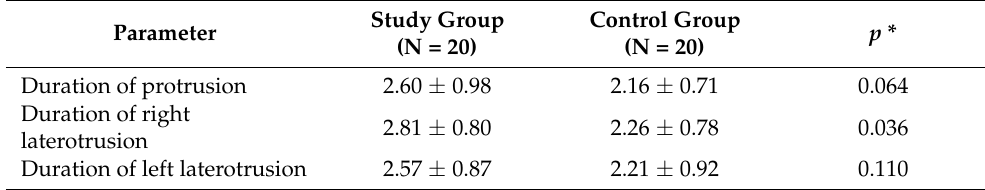
Table 13. Duration of mandibular movements in the two groups of participants (seconds).